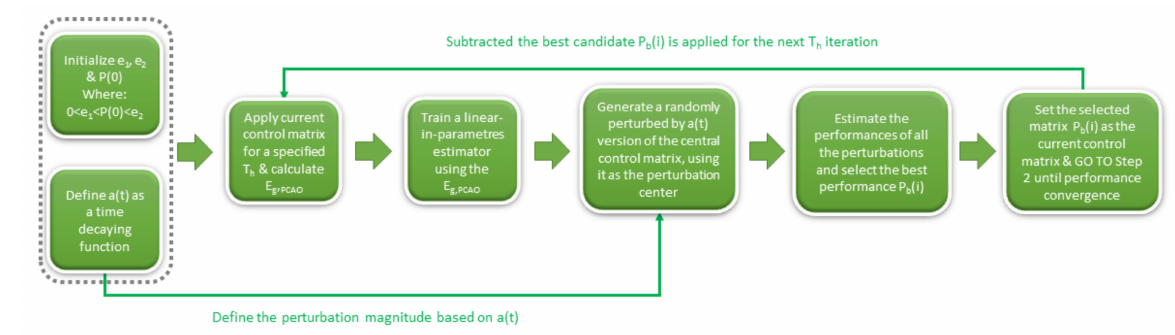
Figure 5. PCAO algorithmic